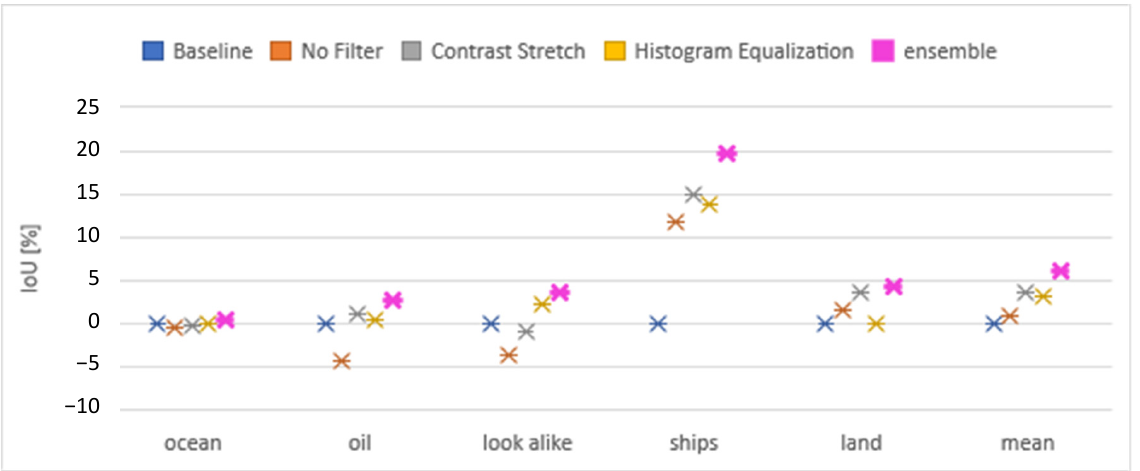
Figure 6. Improvement compared to baseline—DeepLabv3+. The ensemble model achieved a mean IoU score of 71.12%, showing an improvement of ~9.3% compared to the highest score of 65.06% in the baseline research. The ensemble model achieved the following improvements: ~0.3% for the Ocean class, ~4.2% for the Oil Spill class, ~6.2% for the Oil Look-Alike class, 5.2% for the Ship class, and 10% for the Land class, all as compared to the highest performing model in the respective class, as shown in Figure 7. In the baseline research, the highest scores were achieved for either the Unet model or the DeepLabv3+ model, except for the Land class, which achieved its highest score of 63.97% with the LinkNet model.